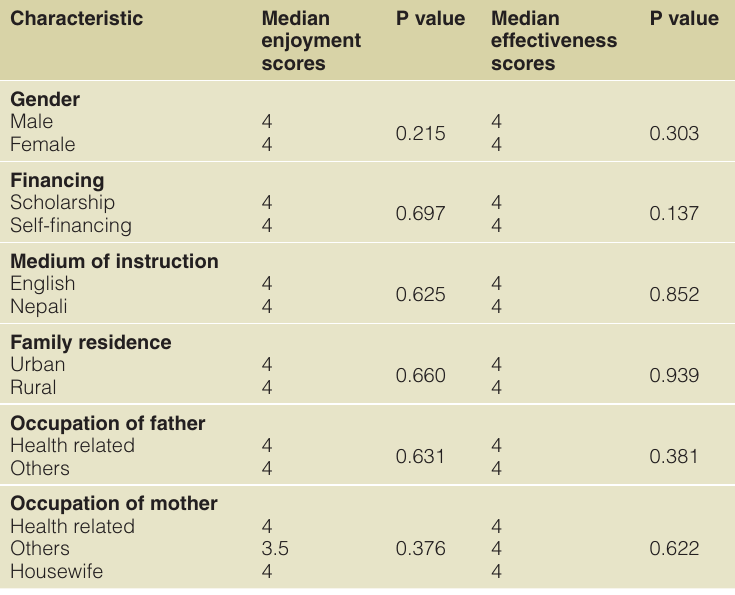
Table 4. Median enjoyment and effectiveness scores according to participants’ personal characteristics.